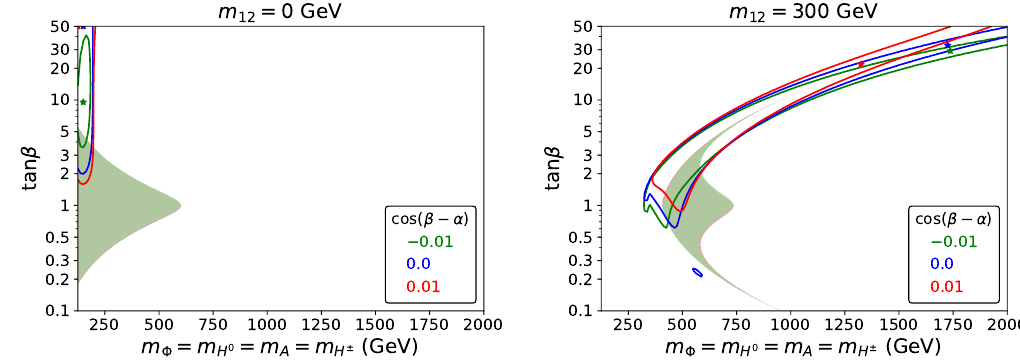
Figure 7 . Allowed region from three-parameter (cid:12)tting results at 95% C.L. in the m (cid:8) (cid:11) ) under CEPC precision for m 12 = 0 GeV (left panel) and 300 GeV (right with varying cos( (cid:12) (cid:0) panel). The color codes are the same as (cid:12)gure